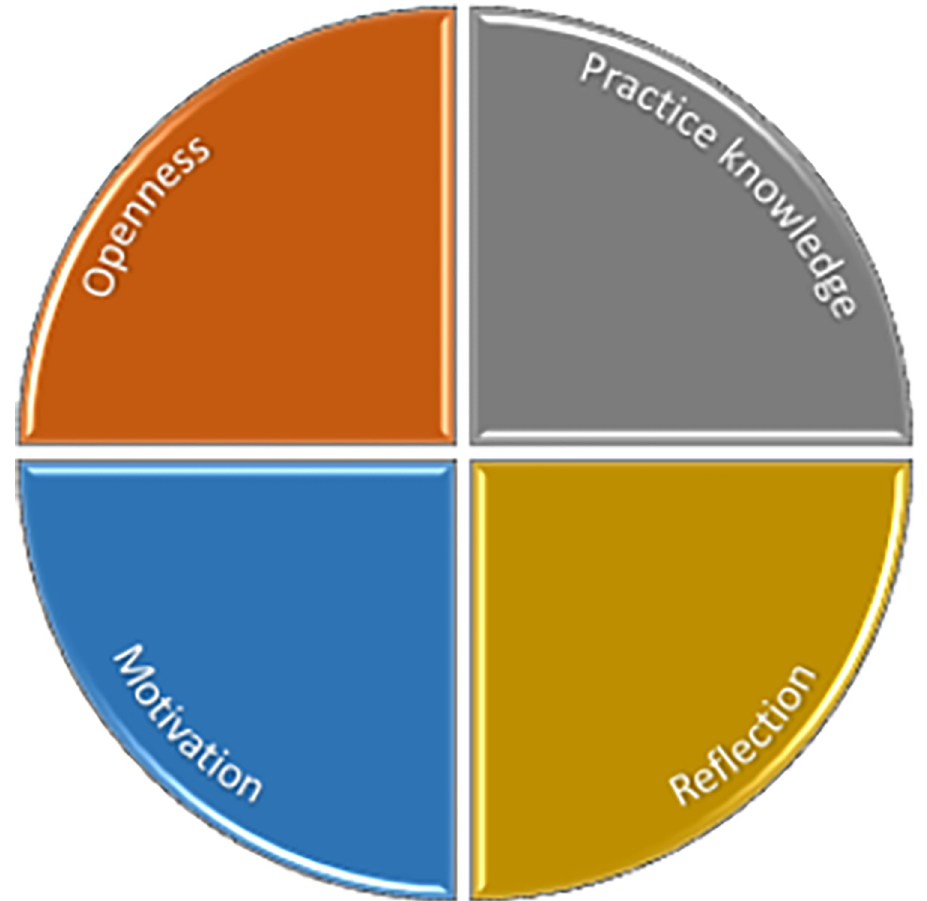
Fig 3. Emerging model of mentoring–mentee